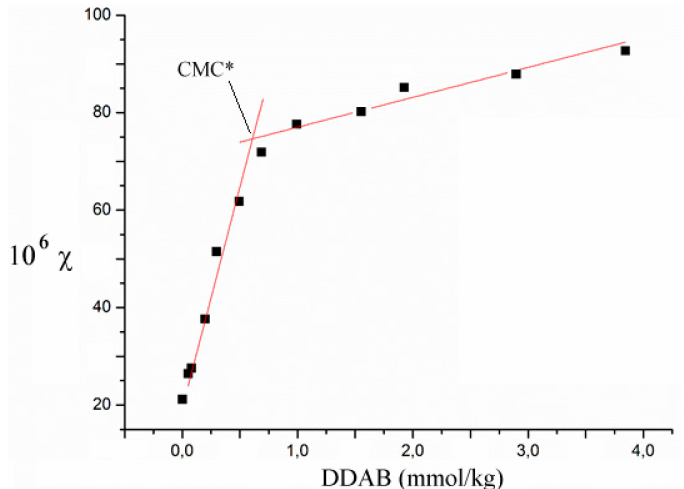
Figure 4 . Conductivity, χ ( μ S cm − 1 ), vs . concentration plot for a 1/1 ss-DNA/CNT system, at 0.010 wt.%, to which progressive amounts of DDAB, in mmol kg − 1 , are added. Data are taken at 25.0